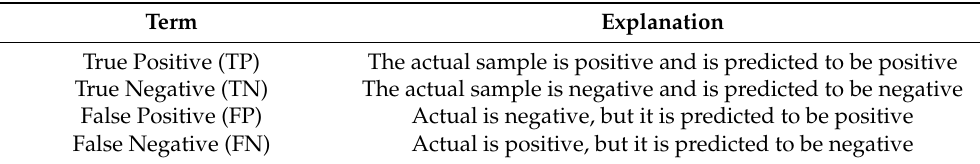
Table 3. Accuracy metric